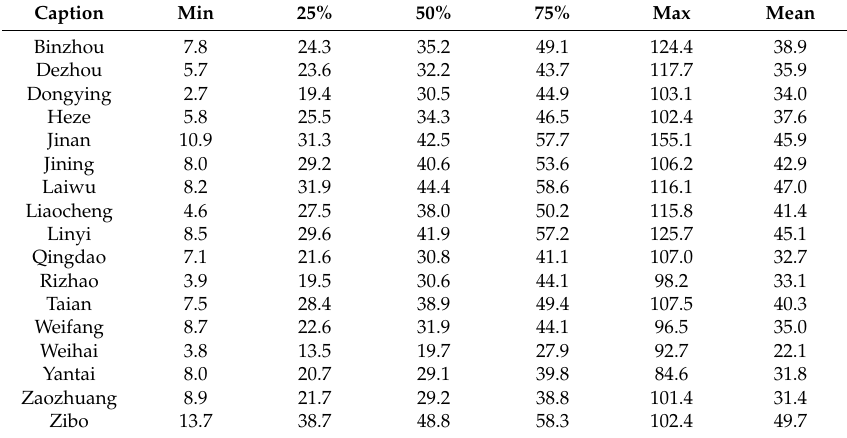
Table A4. Descriptive statistics of the daily mean NO 2 levels ( µ g/m 3 ) in the 17 cities of the Shandong province (from 1 January 2015 to 31 December 2016).